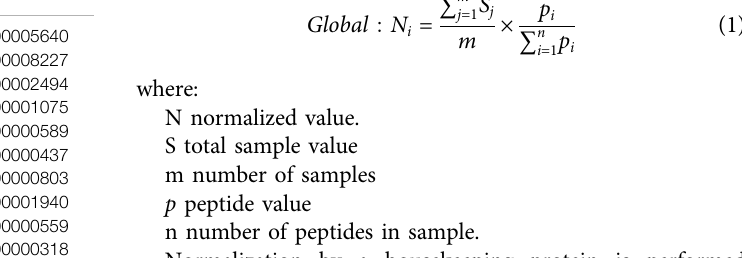
TABLE 2 | The species currently available in the Peptimetric database, alongside the number of proteins and UniProt proteome identi fi er (UPID).